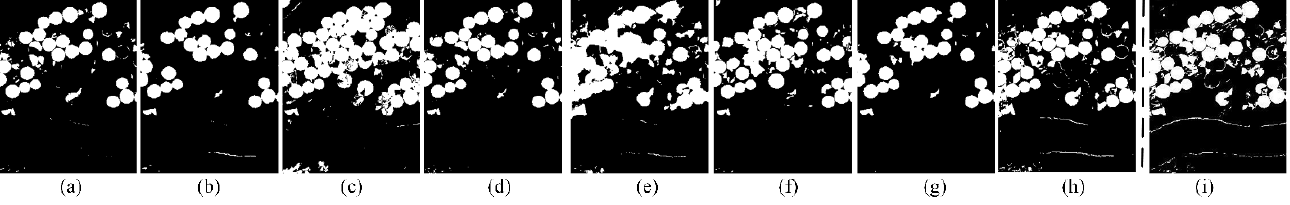
Figure 11. Binary CM of the USA dataset using different methods: ( a ) CVA, ( b ) SSIM, ( c ) ISFA, ( d ) IRMAD, ( e ) MaxtreeCD, ( f ) Unet, ( g ) SGCL, ( h ) SSCF, ( i ) Ground-truth.